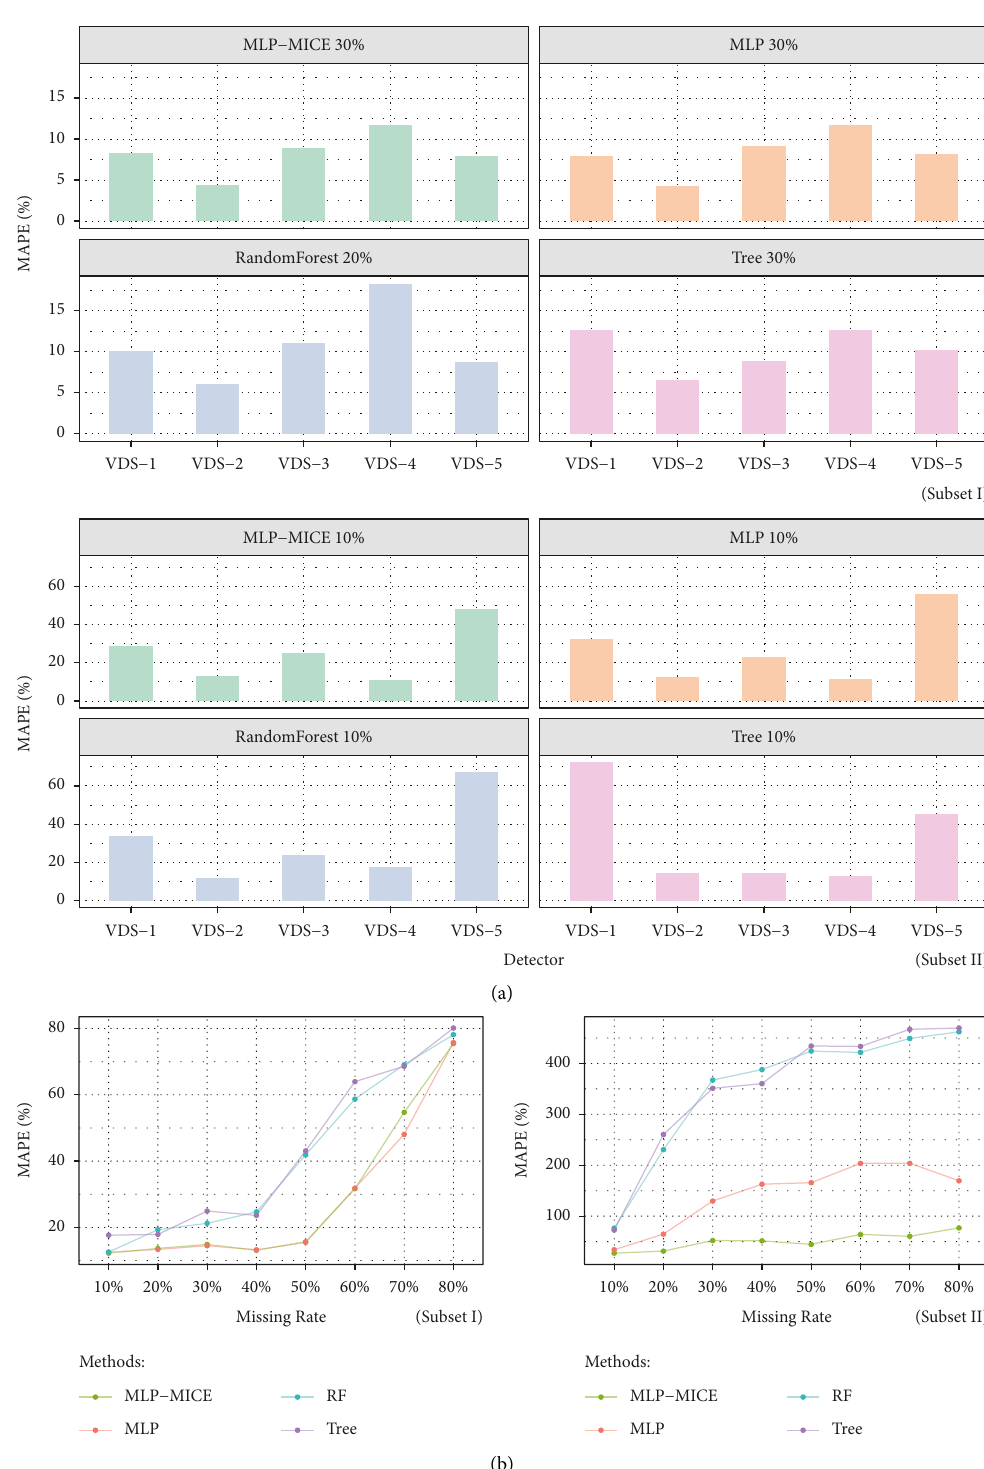
Figure 9: Imputation results and comparison of the proposed model with other models on the same data subset. (a) Continuous missing and (b) jumped